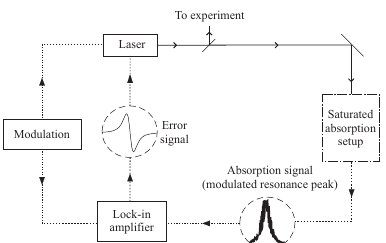
Figure 8. Setup for laser frequency stabilization using a lock-in amplifier. The modulation was provided by a function generator operating at ∼ 7 kHz. A scan controller is used to scan the laser frequency at a rate of ∼ 10 Hz. An example of the saturated absorption setup is shown in Figure 3. A trace of the saturated absorption signal obtained by scanning the laser over a single Doppler-free transition is shown. For illustrative purposes, this trace was recorded with a large amplitude for frequency modulation. The output of the lock-in amplifier generates the corresponding dispersion shaped error signal. To lock the laser to the peak of this resonance line, the laser frequency is centered on the resonance peak, and the scan amplitude is gradually reduced (ideally to zero) before engaging the feedback loop.